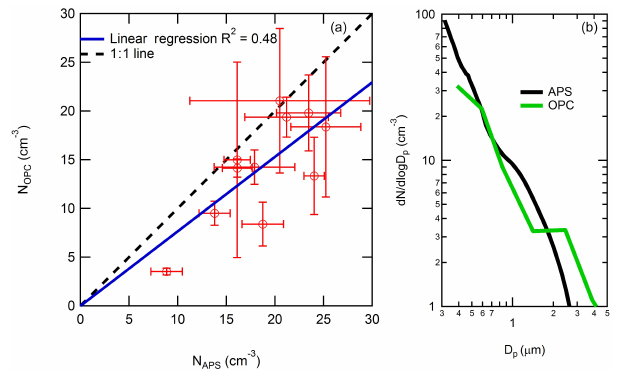
Figure 2. OPC concentrations with particle diameters ( D p ) greater than 0.3µm (a) from 11 UAV research flights, listed in Table 1, plot- ted against APS concentrations ( D p >0.3µm) at Mace Head Atmo- spheric Research Station (red circles). Error bars represent ± 1 stan- dard deviation. The points are fit with a linear regression (blue line). OPC data were averaged between 40 and 80ma.s.l. OPC and APS number size distributions averaged for the 11 flights (b)